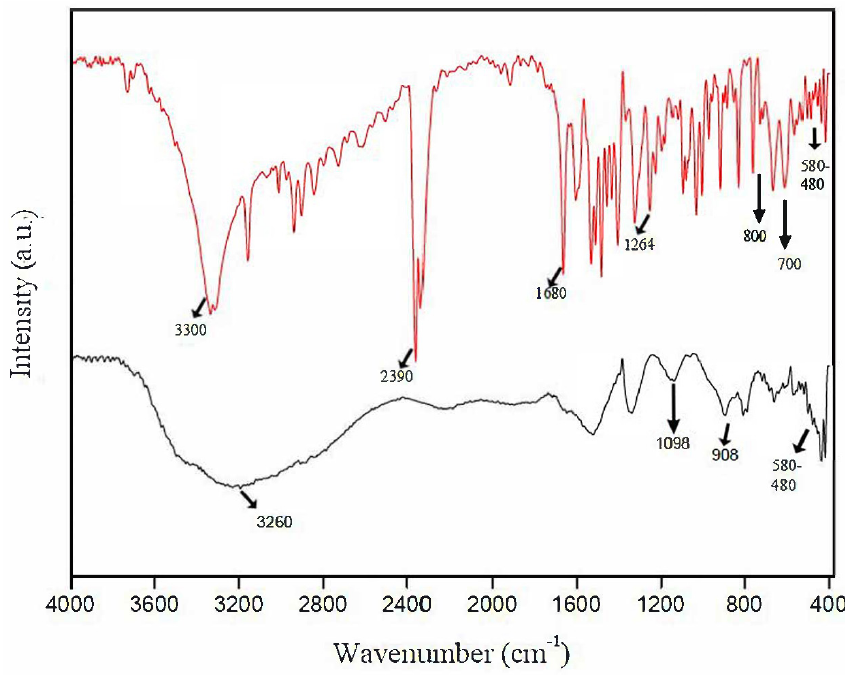
Figure 3. The FTIR spectra of δ -FeOOH/ABT (red line) and δ -FeOOH (black line).